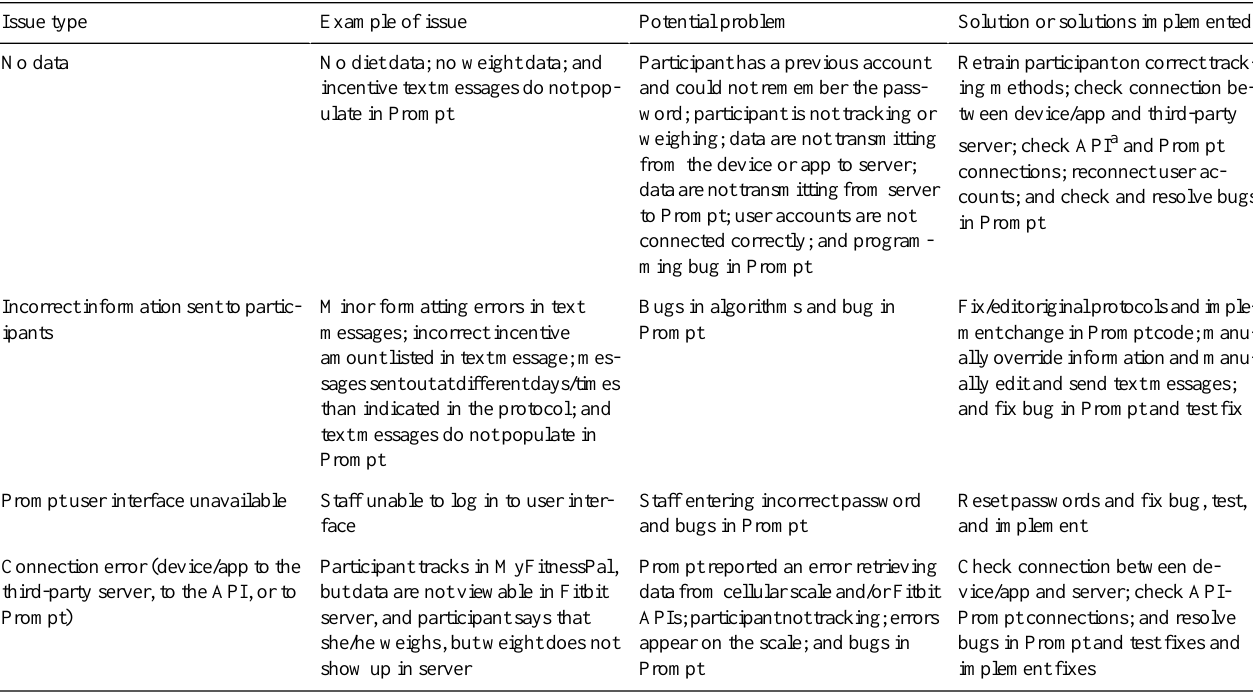
Table 2. Log2Lose software troubleshooting.